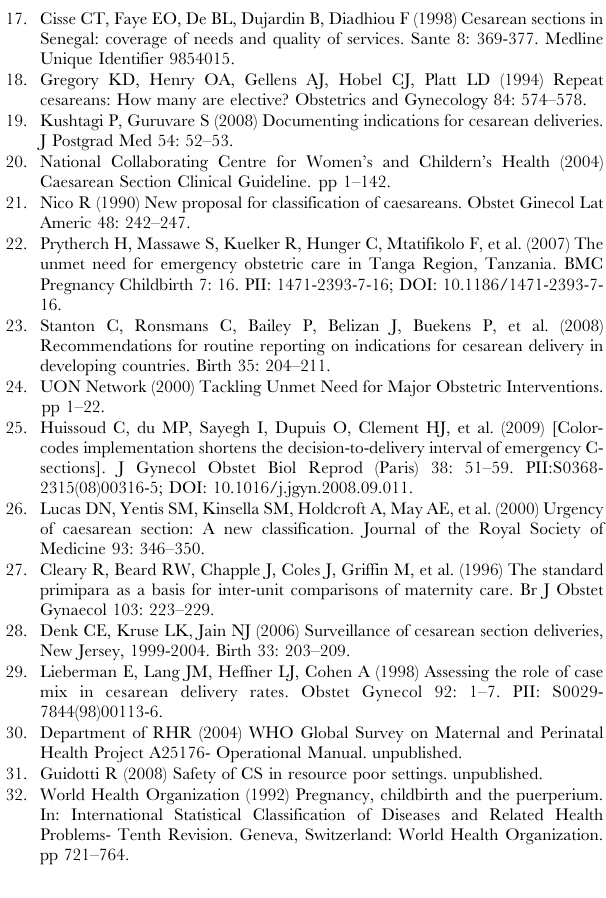
Figure S5 Outline of the 27 classifications for Cesarean sections included in the systematic